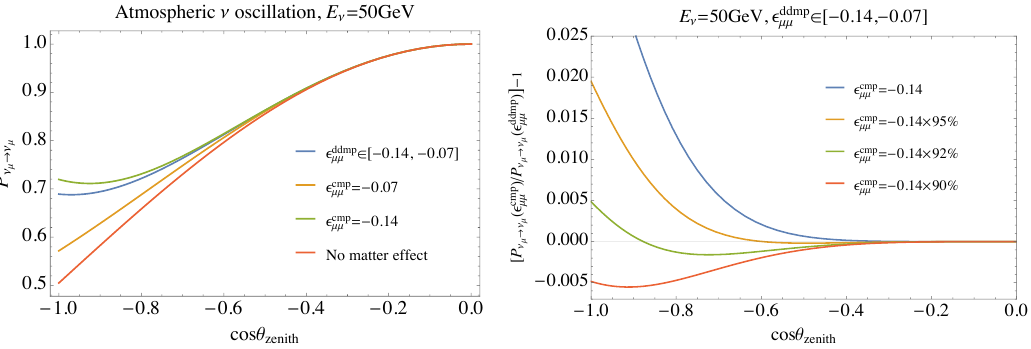
Figure 5 . Left: survival probability of an atmospheric muon neutrino after traveling through the earth and the zenith angle dependence in a gauged L e (cid:0) L (cid:22) model. We consider simpli(cid:12)ed two (cid:13)avor oscillations (cid:23) (cid:22) ! (cid:23) (cid:28) . The blue curve corresponds to a depth dependent matter potential, while the orange and green curves corresponds to constant matter potentials. The red curve is the SM limit muon and tau neutrinos experience identical matter potential. Right: a closer comparison between a depth dependent and several constant matter